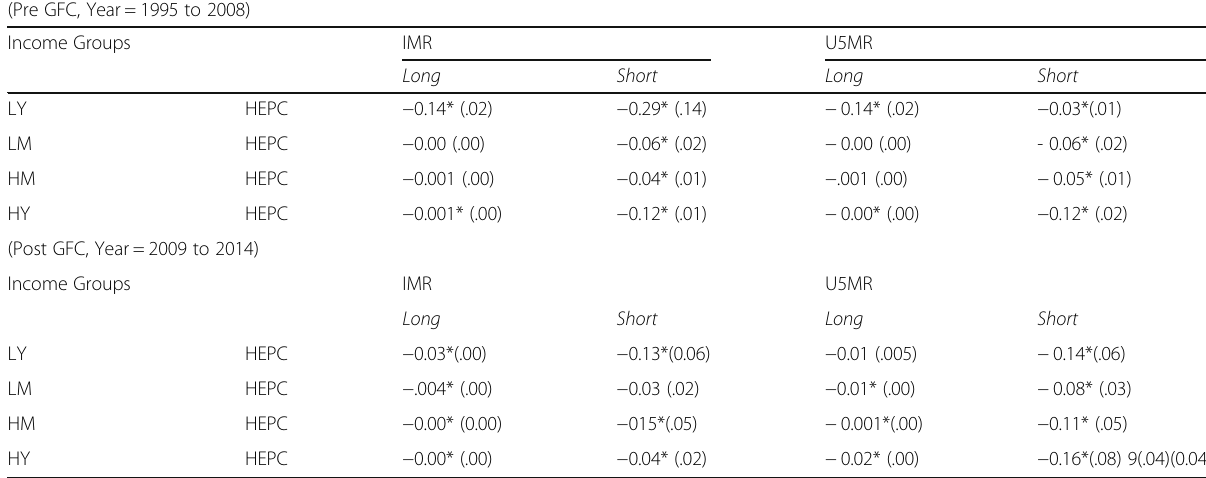
Table 10 Mean group estimation ARDL model (Pre GFC, Year = 1995 to 2008)